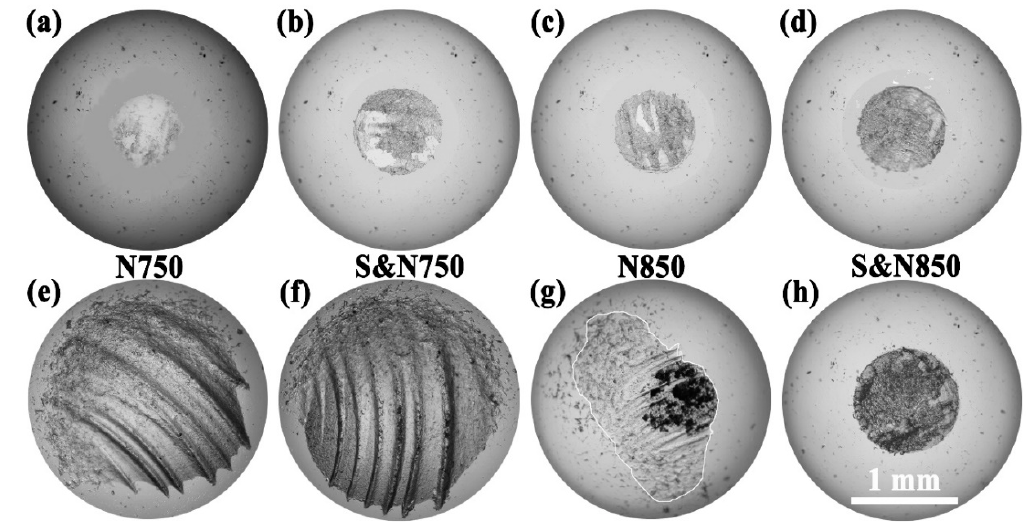
Figure 10. Optical microscope images showing the surface morphologies of the wear scar on the ball sliding against the Ti treated by USRP pre-treatment and plasma nitriding ( a–d ) without and ( e–h ) with abrasive SLRPs.